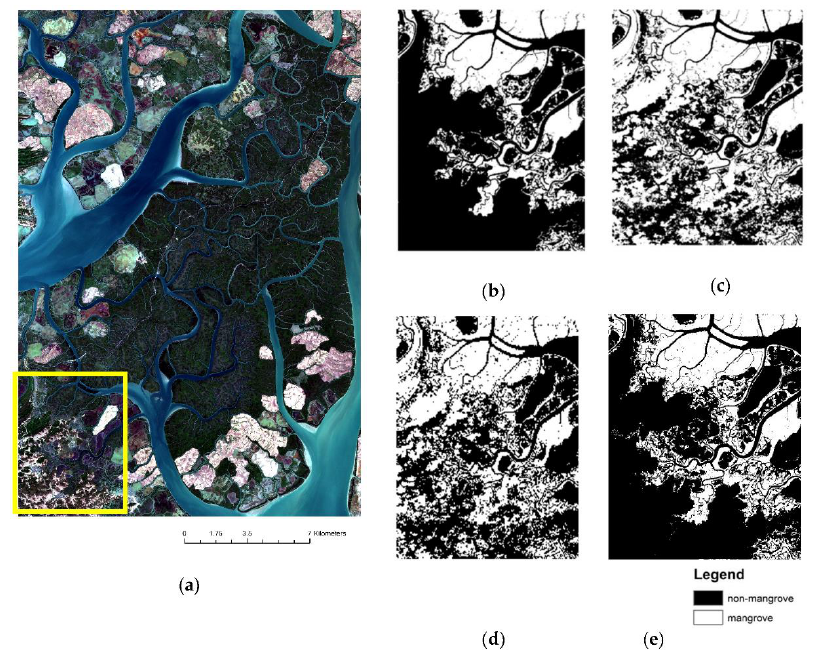
Figure 6. ( a )The study area (Sentinel-2 true color image) and mixed vegetation area in ( b ) ground truth image, classified images of ( c ) Experiment 2, ( d ) Experiment 3, and ( e ) Experiment 6.